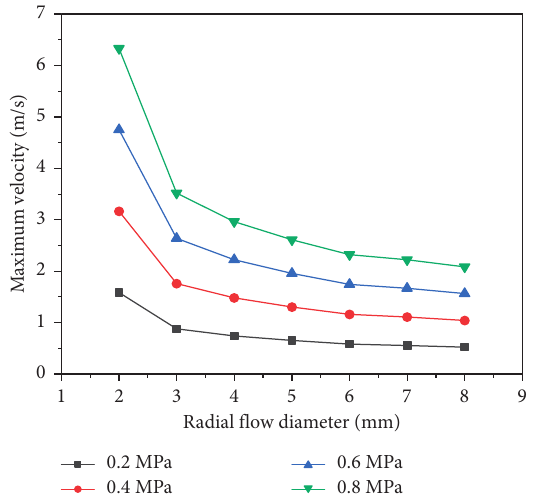
Figure 13: Maximum velocity under different hydraulic pressure rates and different inner diameters.